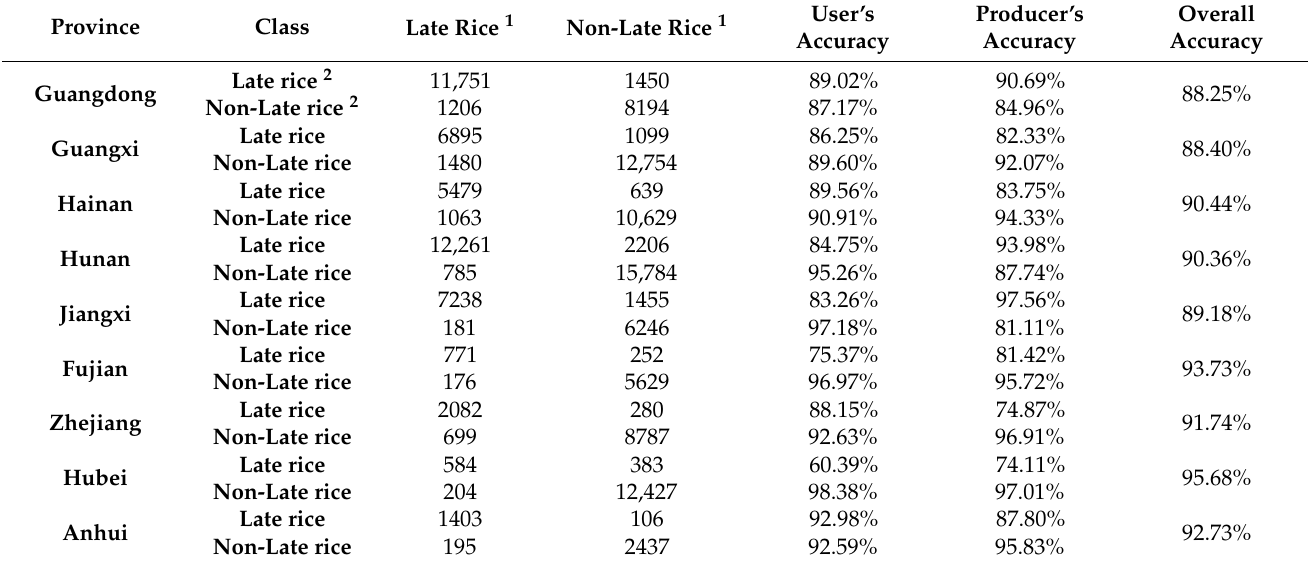
Table 3. Confusion matrix for the identification map of planting areas of Late rice in nine provinces from 2018 to 2020. Province Class Late Rice